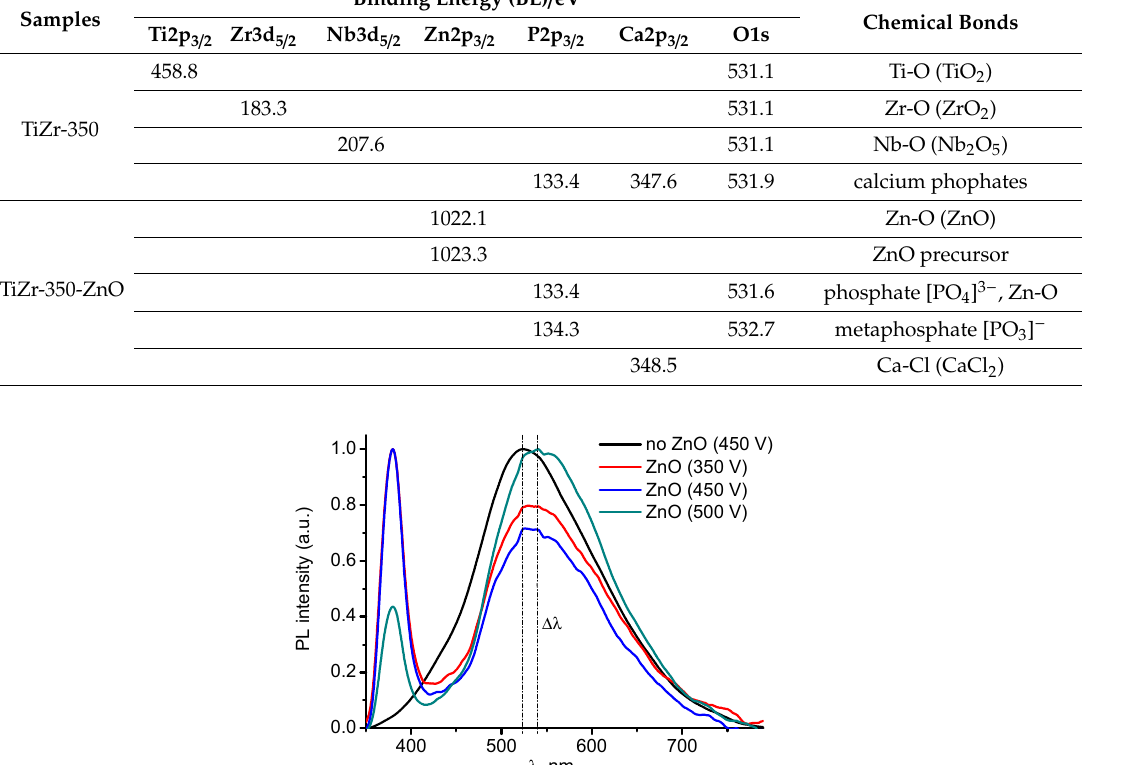
Table 2. The XPS data evaluated from the deconvolution of Ti2p, Zr3d, Nb3d, Zn2p, P2p, Ca2p, O1s XPS spectra recorded for the TiZr-350 and TiZr-350-ZnO samples.